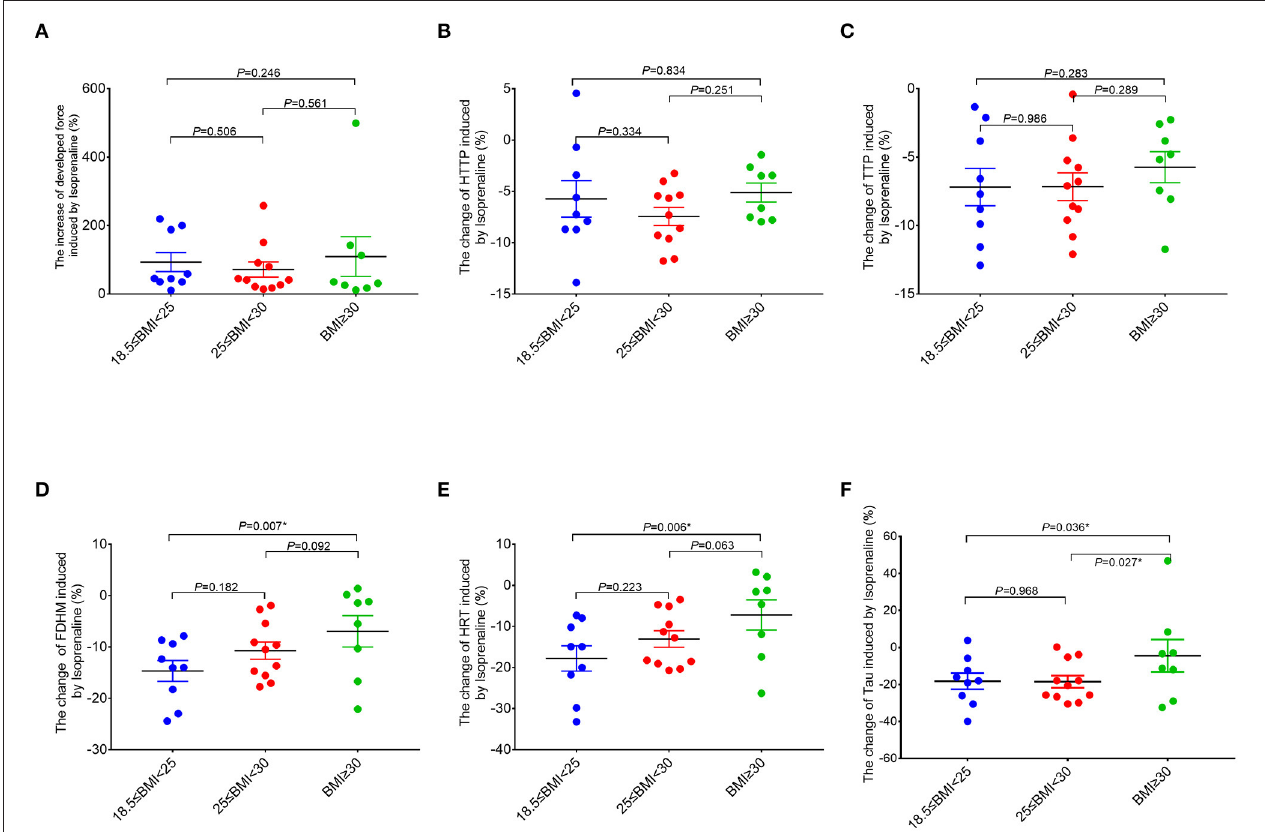
FIGURE 4 | Comparisons of the response of the right atrial trabeculae to isoproterenol between the groups (normal group, n = 9; overweight group, n = 11; obese group, n = 8). In comparison to the normal group (18.5 kg/m 2 ≤ BMI < 25 kg/m 2 ), the ranges of changes of FDHM, HRT, and Tau caused by isoproterenol in the obese group (BMI ≥ 30 kg/m 2 ) are significantly smaller (by using the X-axis zero point as the reference line). *Compared to the obese group (BMI ≥ 30 kg/m 2 ), p < 0.05. All the data are normalized to baseline. Data are expressed as mean ± SEM. BMI, body mass index; HTTP, half time to peak force; TTP, time to peak force; FDHM, full duration at half maximum; HRT, half relaxation time; Tau, relaxation time